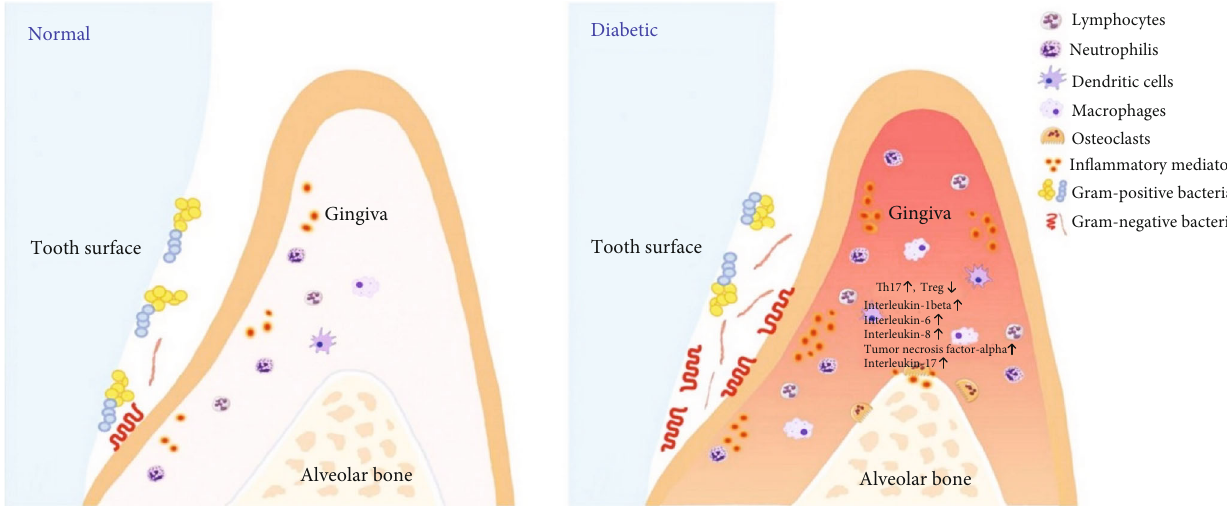
Figure 2: Diabetes enhances in fl ammation in the periodontium leading to changes in bacterial composition. Diabetes results in more in fl ammation mirrored by increased leukocytes and cytokine expression, as well as a change in bacterial composition that improves the overall pathogenicity of the microbiota